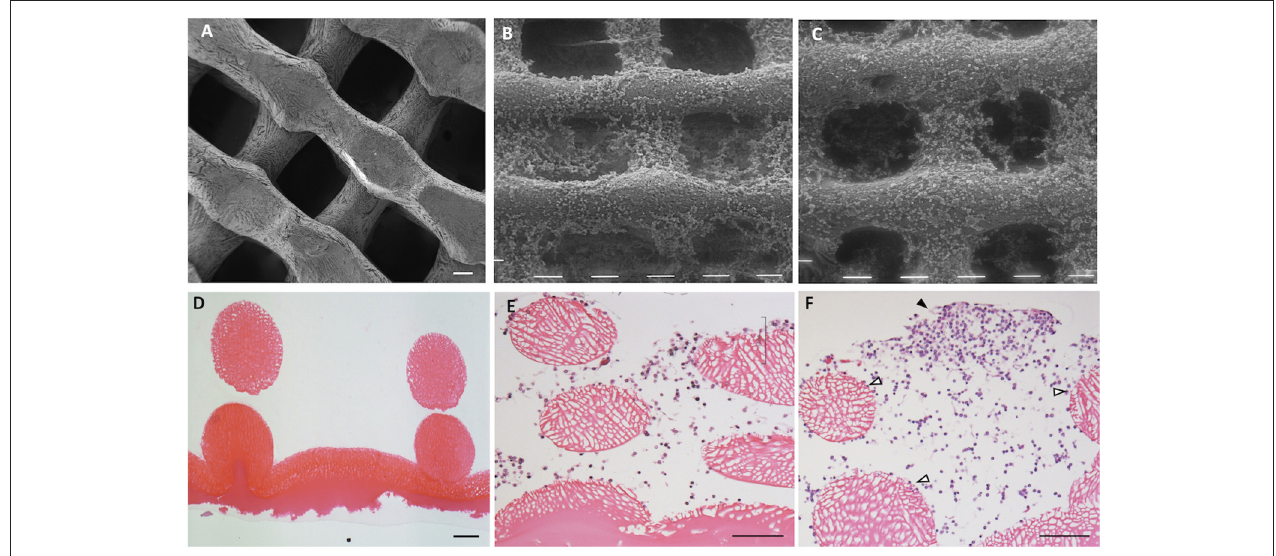
FIGURE 1 | Chitosan scaffold at scanning electron microscopy (SEM) (A–C) and at light microscopy (hematoxylin–eosin staining; D–F ). The structure of chitosan scaffold without cells (A,D) . Chitosan scaffold (B,E) and chitosan scaffold functionalized with hyaluronic acid (HA) (C,F) with chondrocytes after 2 weeks of culture. Black tips: cell cluster; white tips: single cells. Scale bar = 100 µ